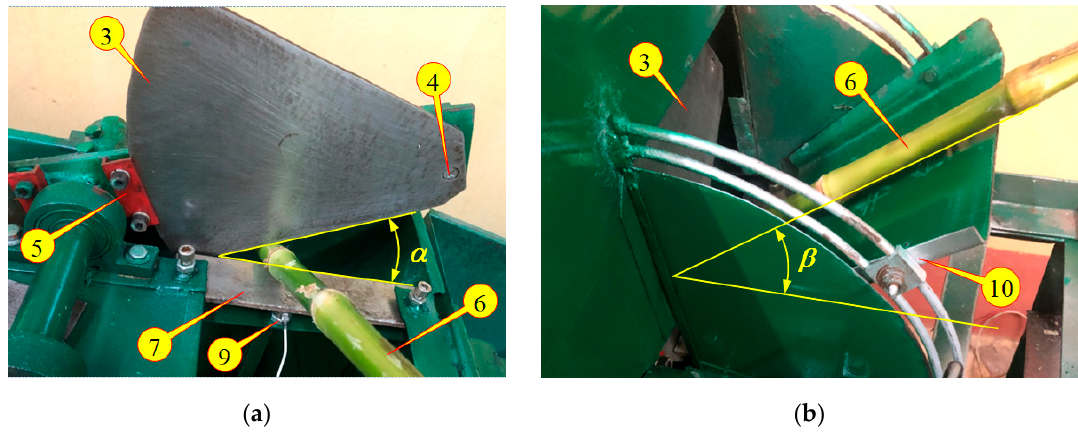
Figure 2. Practical experimental setup: (a) a front view (the protection cover was opened) and (b) a side view: (3) knife; (4) screw; (5) clamp; (6) maize stalk; (7) counter shear; (8) torque sensor; (9) force sensor and (10) clamp set